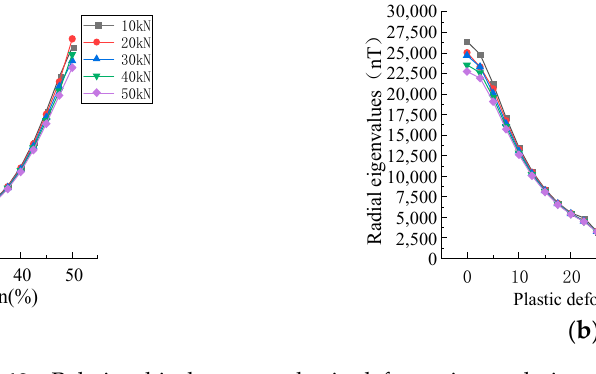
Figure 10. Relationship between plastic deformation and eigenvalues under different stresses. ( a ) The relationship between plastic deformation under different stresses and the eigenvalues of axial component of MFL signals. ( b ) The relationship between plastic deformation under different stresses and the eigenvalues of radial component of MFL signals.